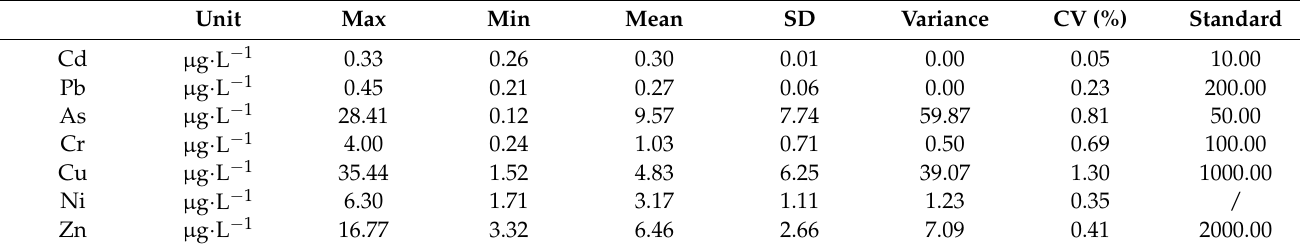
Table 4. HM content in irrigation